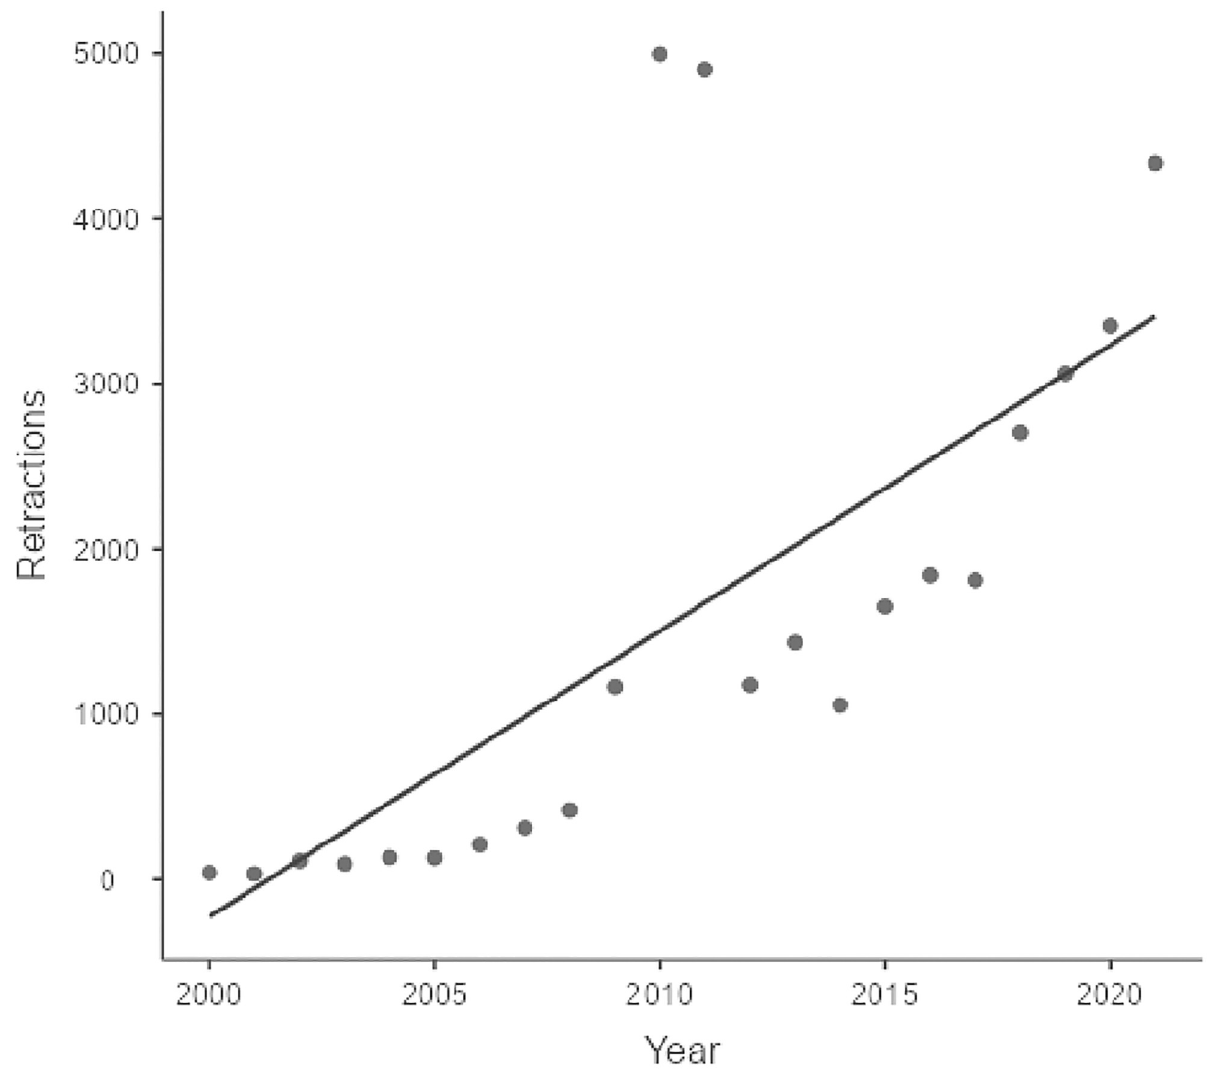
Fig 1. Number of retractions and other notices from 2000 to 2021 according to Retraction Watch . Linear trend